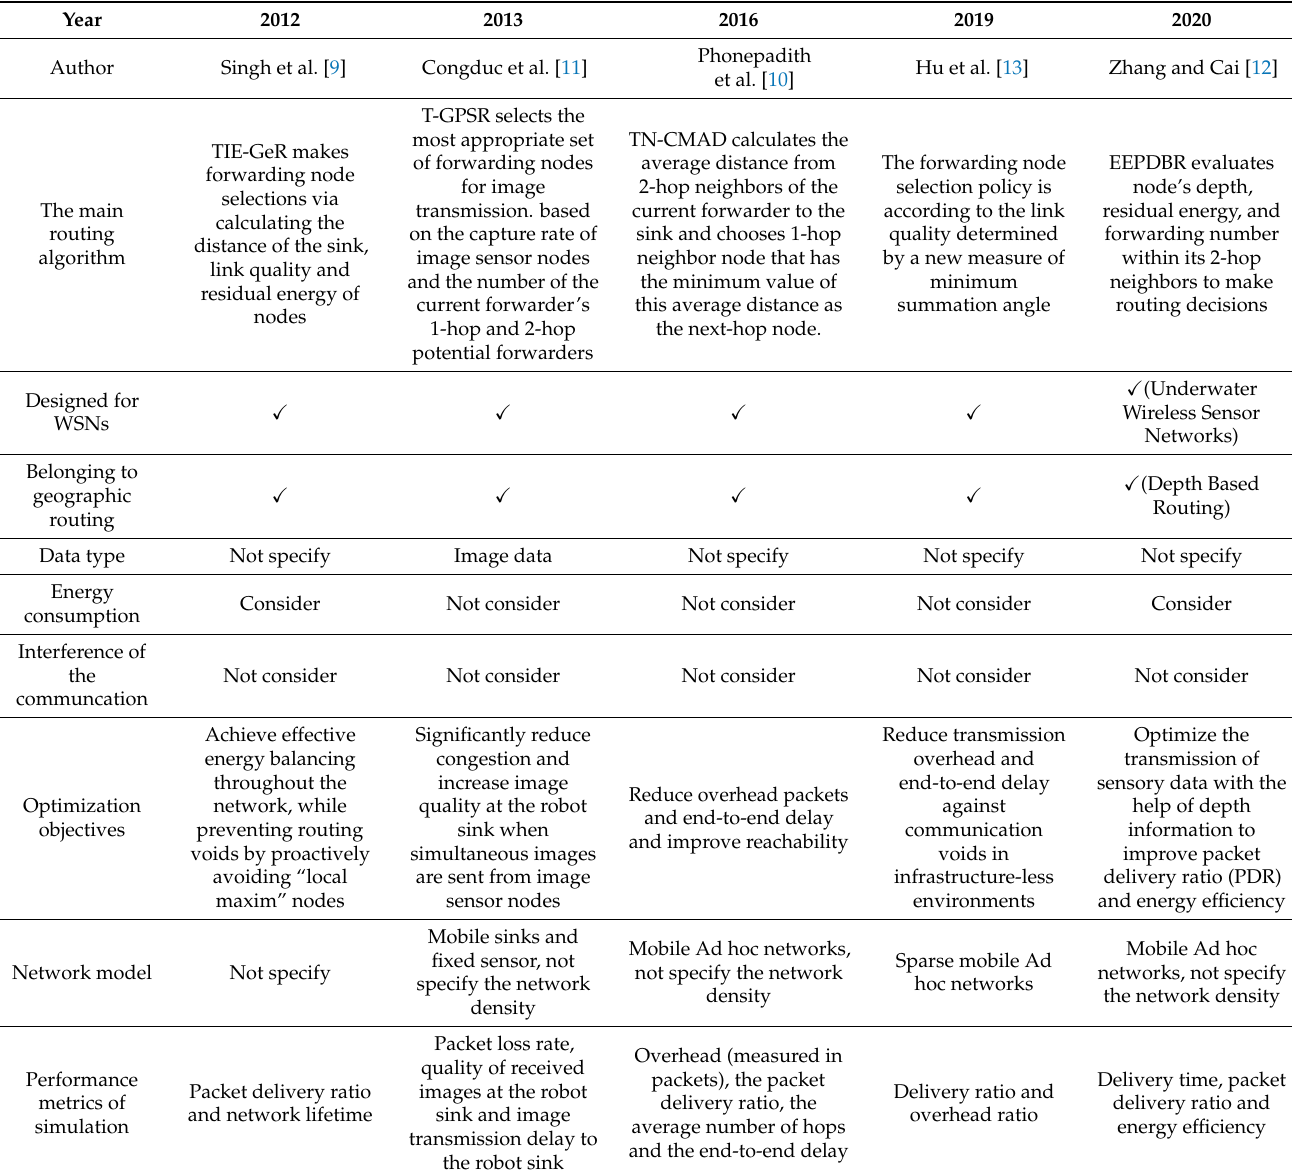
Table 2. Two-Hop Neighbors Information Based